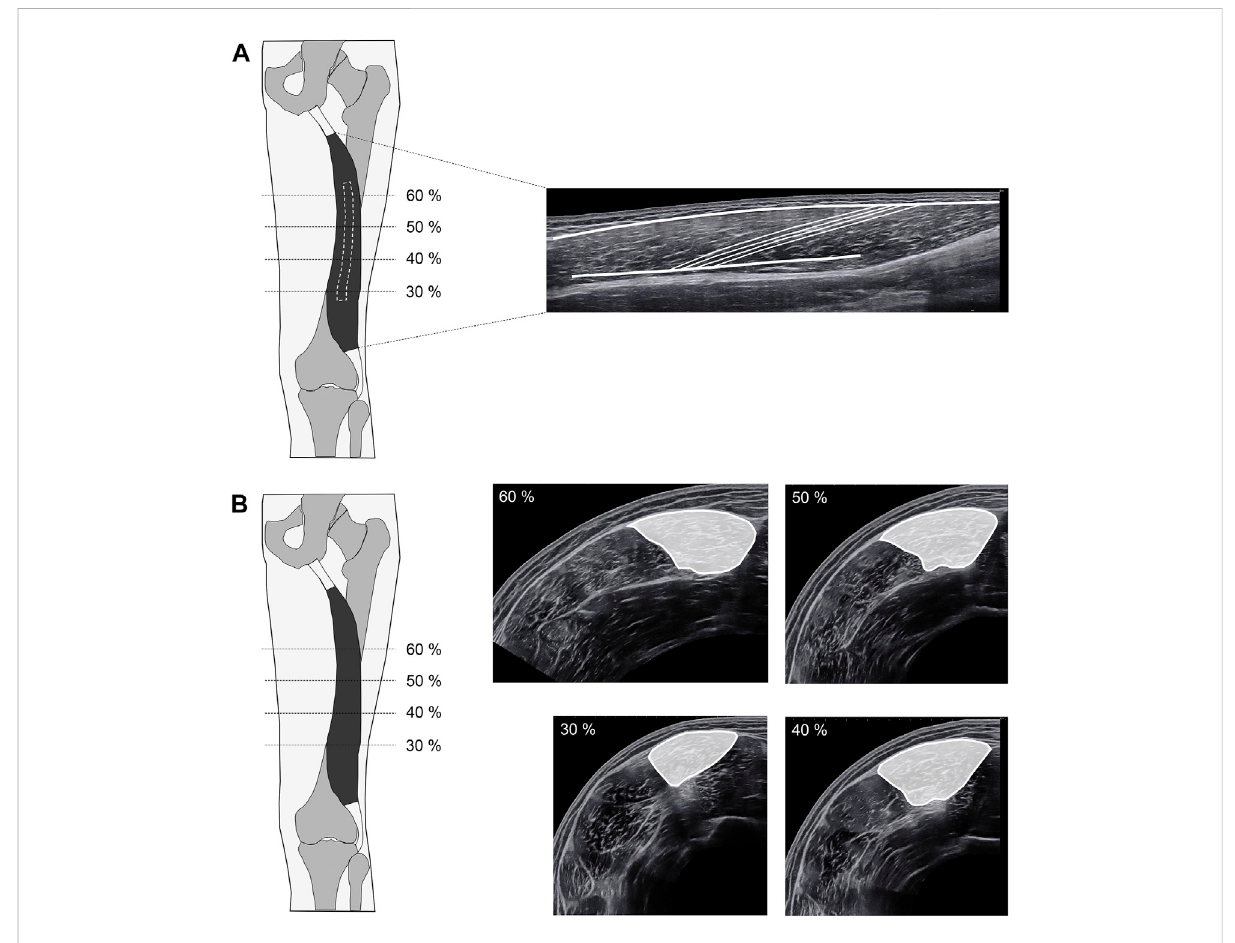
FIGURE 1 Exemplary ultrasound scans. (A) Longitudinal scan; (B) transversal